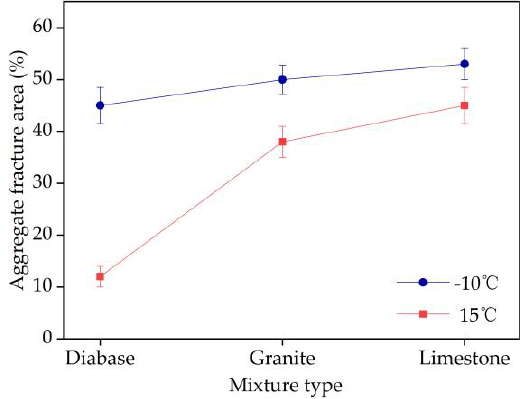
Figure 13. Aggregate fracture area ratio of specimen cross sections.